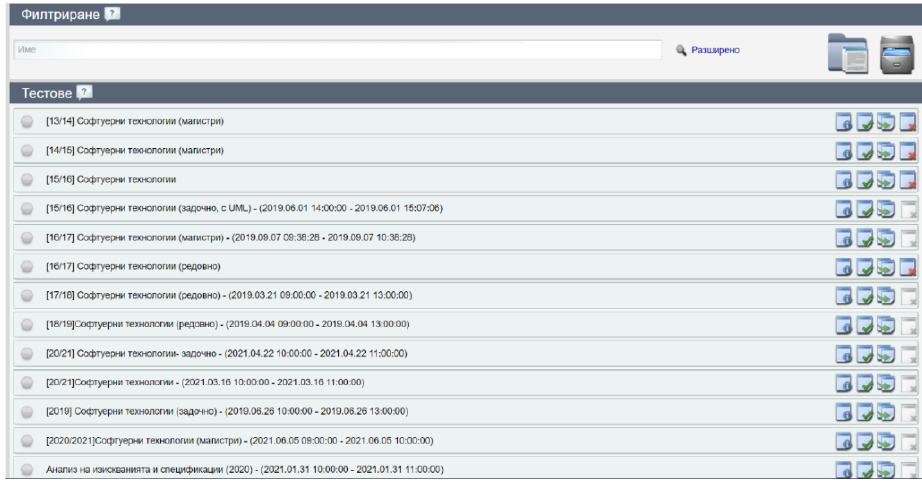
Figure 5. Test Editor (in Bulgarian).